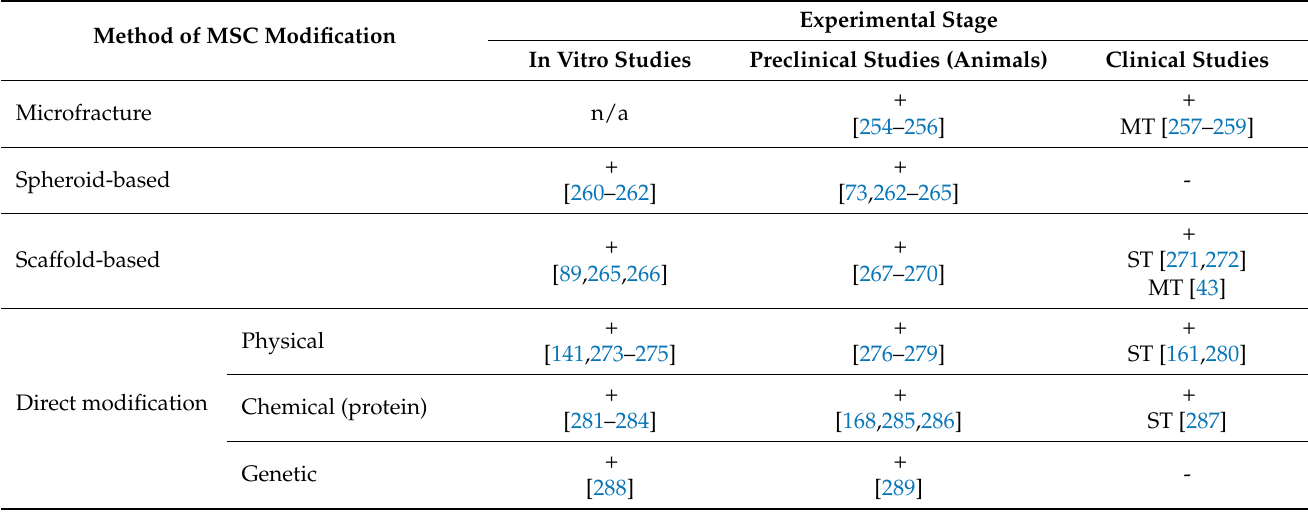
Table 3. Timeline of MSC modification methods and results of recent studies for each stage (last 5 years publications). Method of MSC